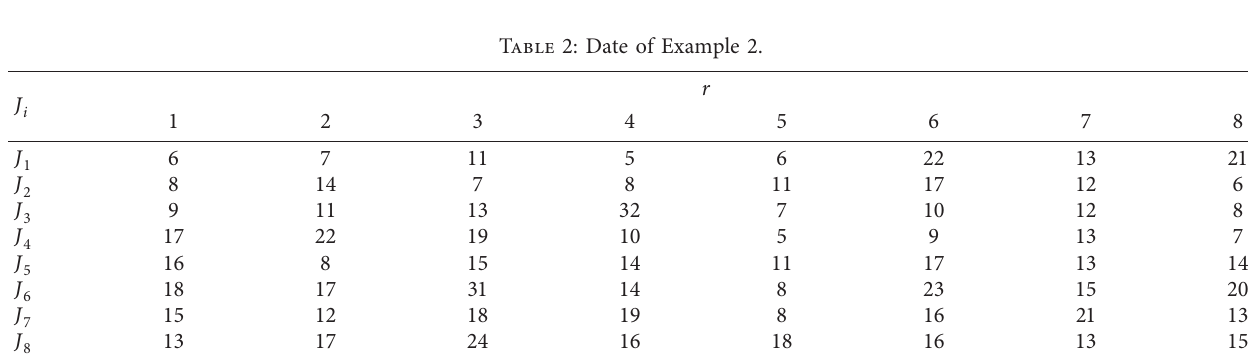
Table 2: Date of Example 2.